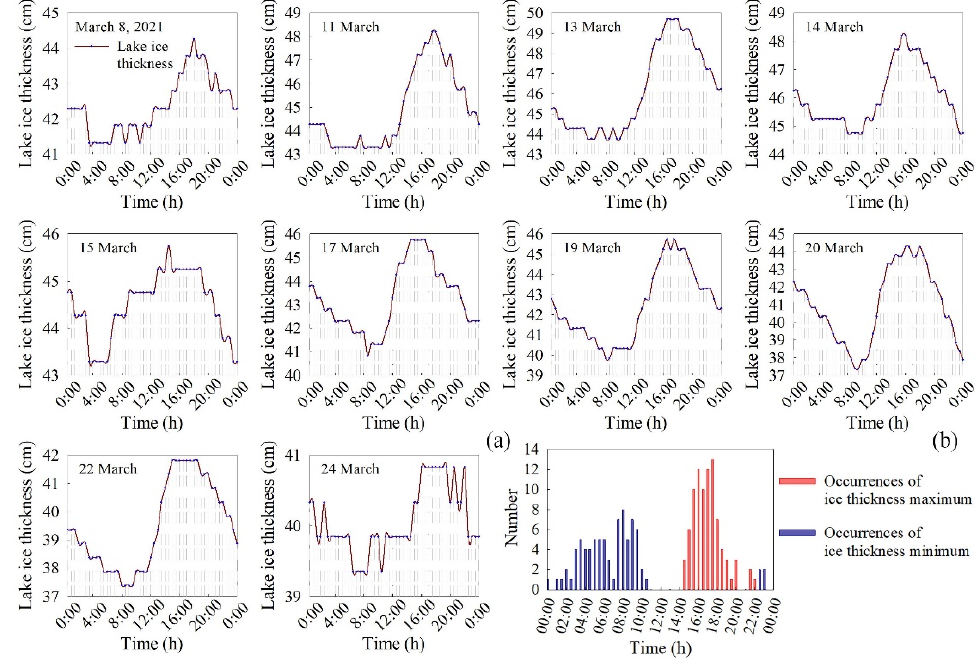
Figure 6. Variations of lake ice thickness on different dates ( a ) and statistics of time when ice thickness reached its maximum and minimum ( b ).